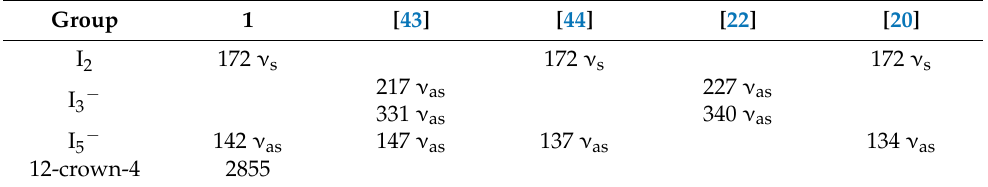
Table 1. Raman shifts of iodine moieties in the samples [Cu(H 2 O) 6 (12-crown-4) 5 ]I 6 · 2I 2 (1) (cm − 1 ).